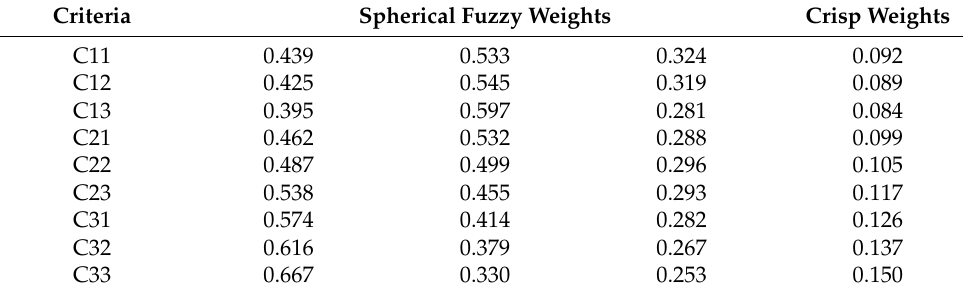
Table 4. Results from the SF-AHP